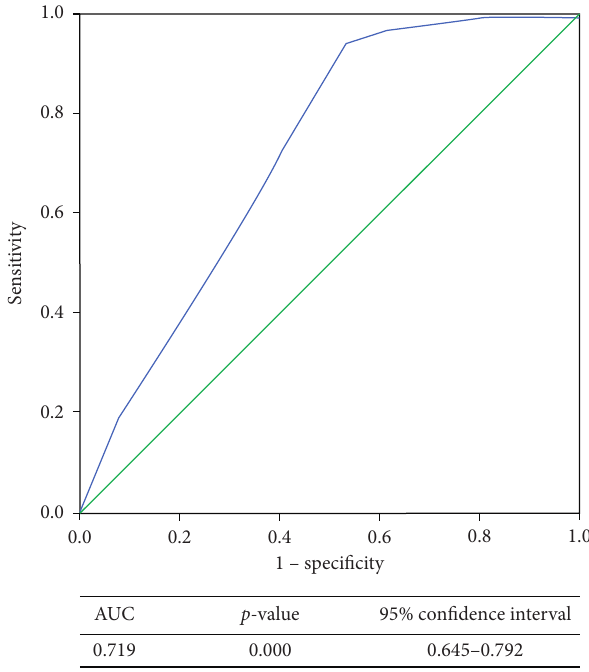
Figure 1: ROC curve.